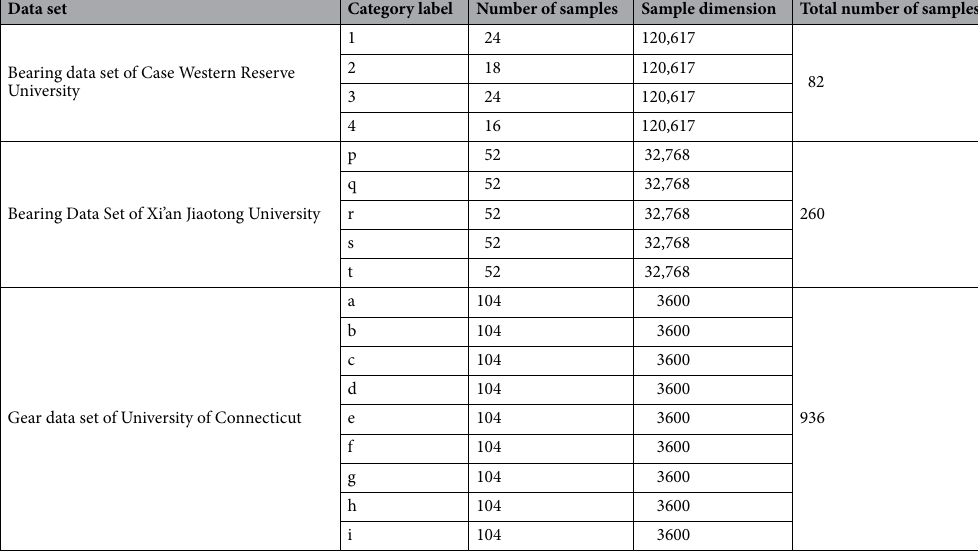
Table 1. Dataset characteristics.